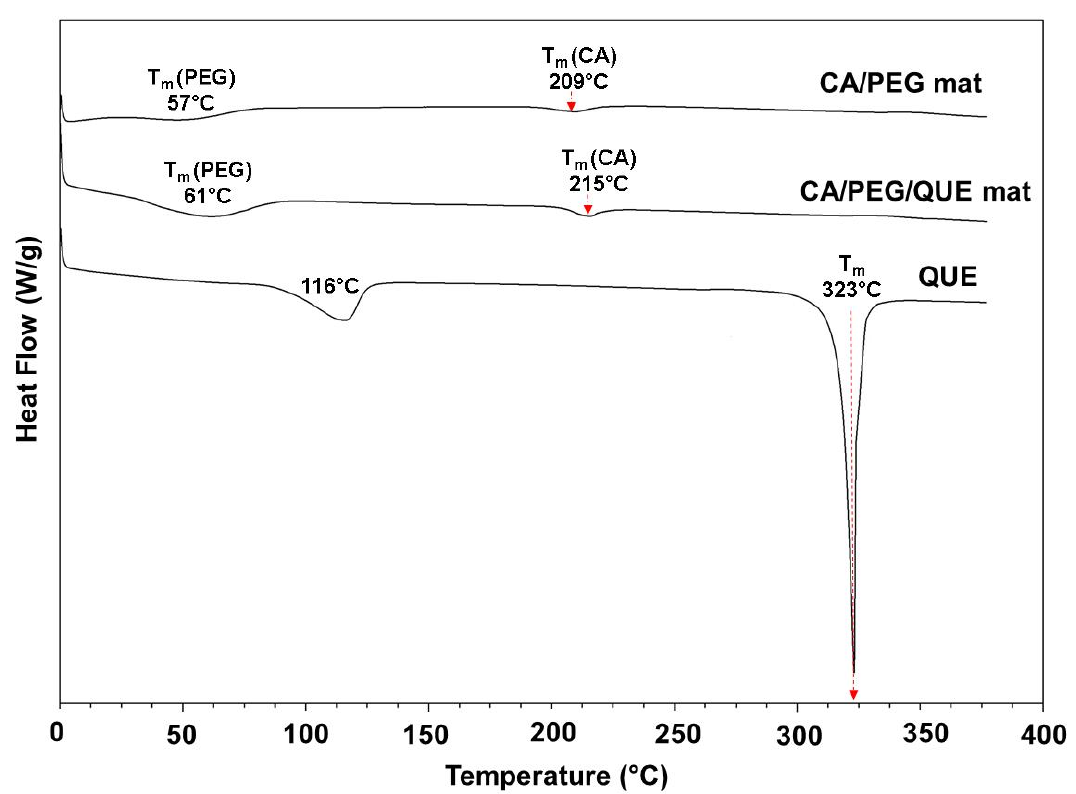
Figure 5. DSC thermograms (first heating run) of: quercetin powder (QUE), CA/PEG/QUE mat, and CA/PEG mat.